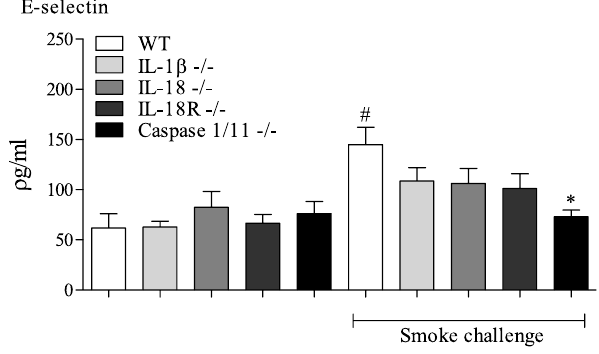
Figure 5. Role of the IL-1 b and IL-18 in CS-driven model. IL-1 b , IL-18, IL-18R or caspase 1/11 -/- mice were exposed to CS or room air (control) twice daily for 3 consecutive days alongside wild-type controls. Lung tissue was collected 24 hours after the last exposure for measurement of E-selectin levels. Data are represented as mean 6 S.E.M. for n=8 animals in each group. Statistical significance was determined using Mann-Whitney U test. # =P , 0.05, denoting a significant difference between the smoke exposed and air exposed wild-type groups; * =P , 0.05, denoting a significant difference between the smoke exposed knock-outs and wild-types (one-way ANOVA).